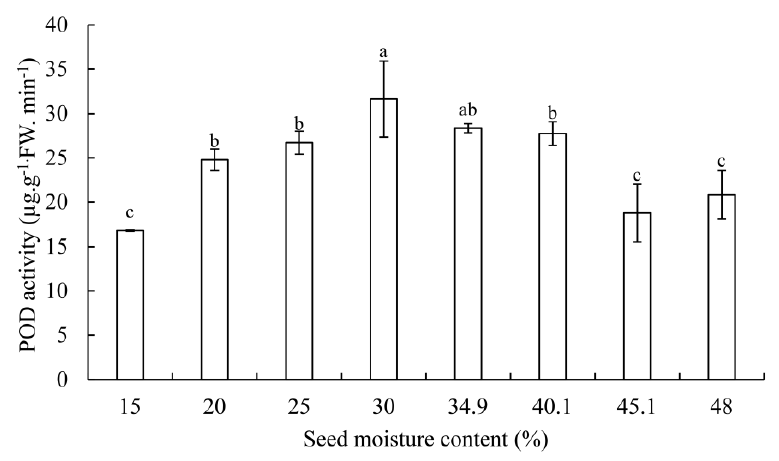
Figure 6. Changes of peroxidase (POD) activity in G. biloba seed embryos during desiccation. Data are means of three replicates ± SD, and bars labeled with the same lower-case letter do not differ significantly at the 0.05 probability level.